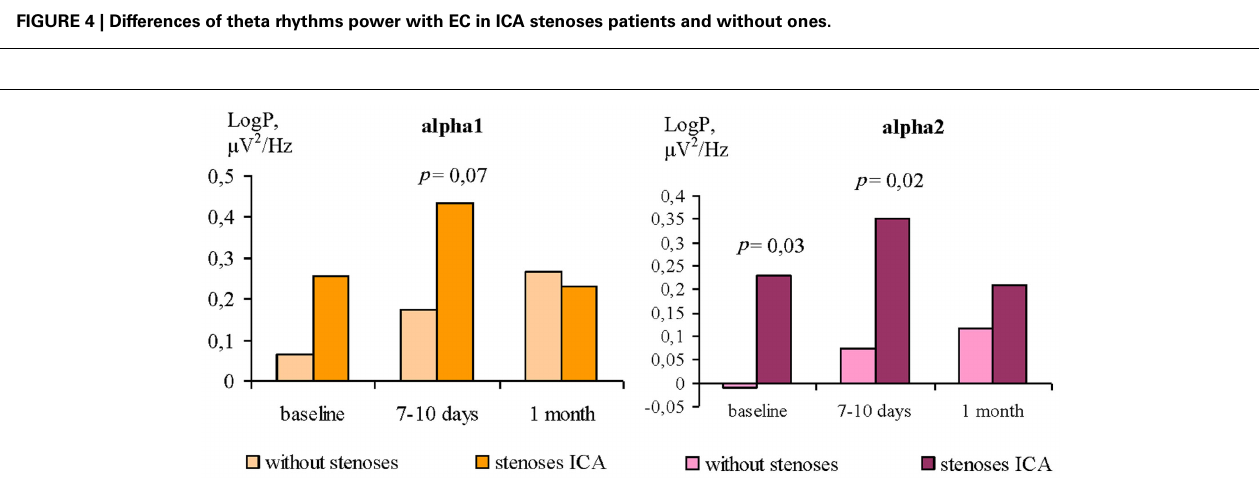
FIGURE 5 | Differences of alpha rhythms power with EO in ICA stenoses patients and without ones.